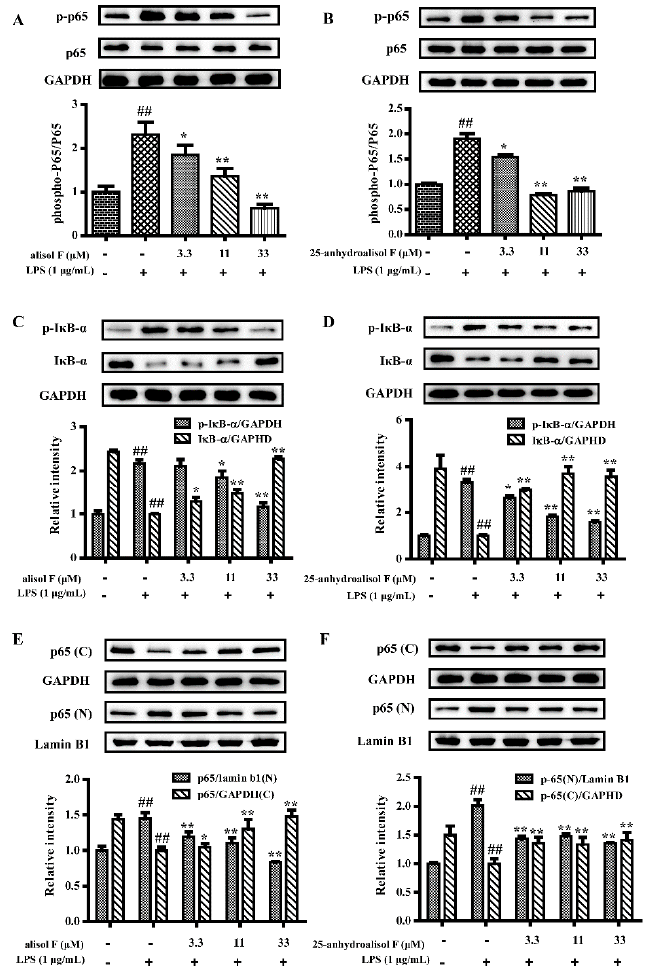
Figure 4. The effect of alisol F and 25-anhydroalisol F on LPS-induced activation of the NF- κ B pathway in RAW264.7 cells. Cells were pretreated with the various concentrations of alisol F (0, 3.3, 11 and 33 μ M) and 25-anhydroalisol F (0, 3.3, 11 and 33 μ M) for 2 h and then stimulated with or without LPS (1 μ g/mL) for 30 min. The expression of phospho-p65, p65, phospho-I κ B- α and I κ B- α were analyzed by Western blot ( A – D ); Cytosolic (C) and nuclear (N) protein were extracted to determine the expression of p65 by Western blot ( E , F ). The data represent the means ± S.E. of three independent experiments. ( ## p < 0.001 vs. control group; * p < 0.05; ** p < 0.001 vs. LPS group).